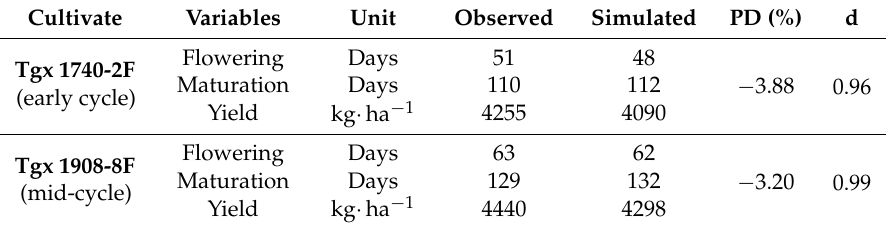
Table 5. Average values of observed and simulated yields with CSM-CROPGRO-Soybean for Tgx 1740-2F and Tgx 1908-8F cultivars—sown in the harvest of 2009/2010 in Angónia, Tete Province,